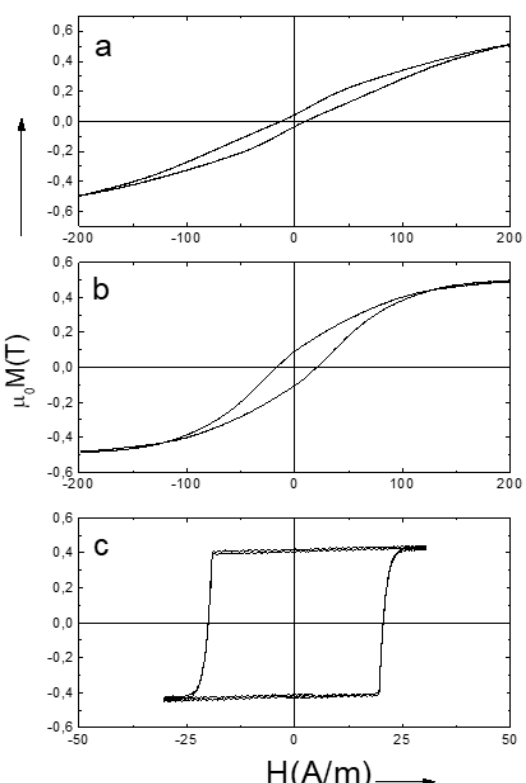
Figure 13. Hysteresis loops the microwire № 6. ( a ) x = 0.08, ( b ) x = 0.09, ( c ) x = 0.1. Reprinted with permission from [45].